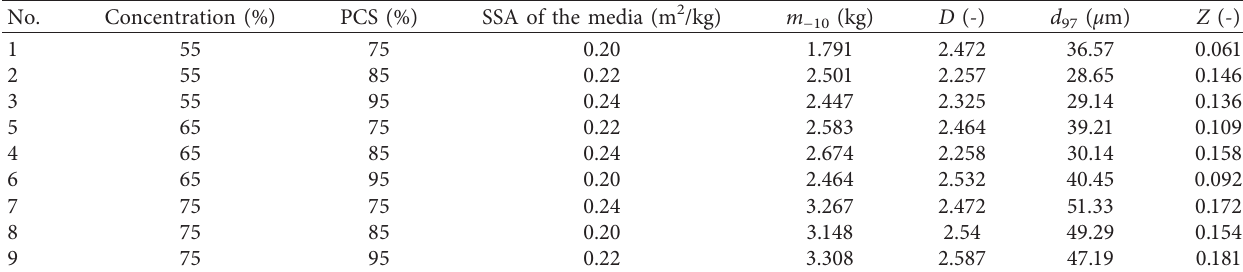
Table 4: Results of the orthogonal